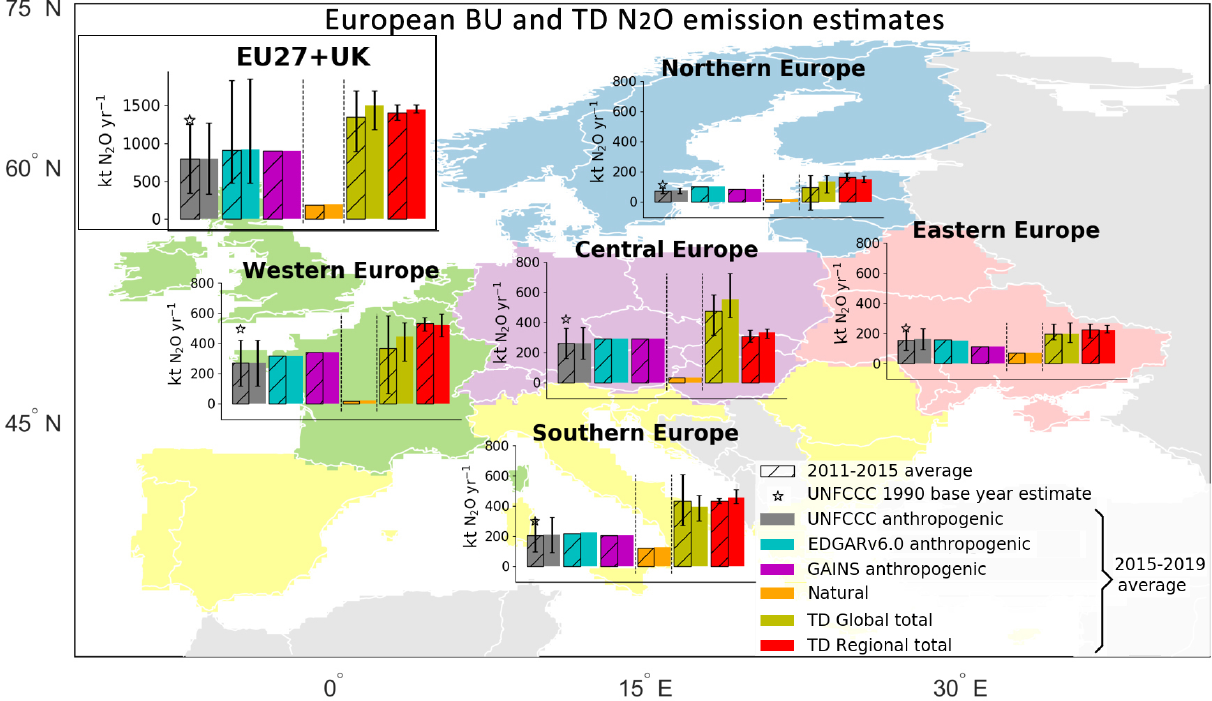
Figure 10. Five-yearly means (2011–2015 hashed bars and 2015–2019 full bars) in total N 2 O emission estimates (excluding LULUCF) for the EU27 + UK and five European regions (northern, western, central, southern and eastern non-EU). The eastern European region does not include European Russia, northern Europe includes Norway and central Europe includes Switzerland. The data are from the UNFCCC NGHGI (2021) submissions (gray), which are plotted with respective base year 1990 (black star) estimates; two inventories (GAINS and EDGARv6.0); natural unmanaged emissions (lake, river and reservoir emissions from RECCAP2 and natural N 2 O from O-CN); and two inversion total estimates (one regional European inversion (FLEXINVERT) and the average of three global inverse models from GN 2 OB, Tian et al., 2020). The relative error on the UNFCCC value represents the NGHGI (2021) reported uncertainties computed with the error propagation method (95% confidence interval) and gap-filled to provide respective estimates for each year (see Appendix A); for eastern Europe non-EU the uncertainty value of 42.3% was calculated from the NIRs. Northern Europe Tier 1 uncertainty for Norway was not